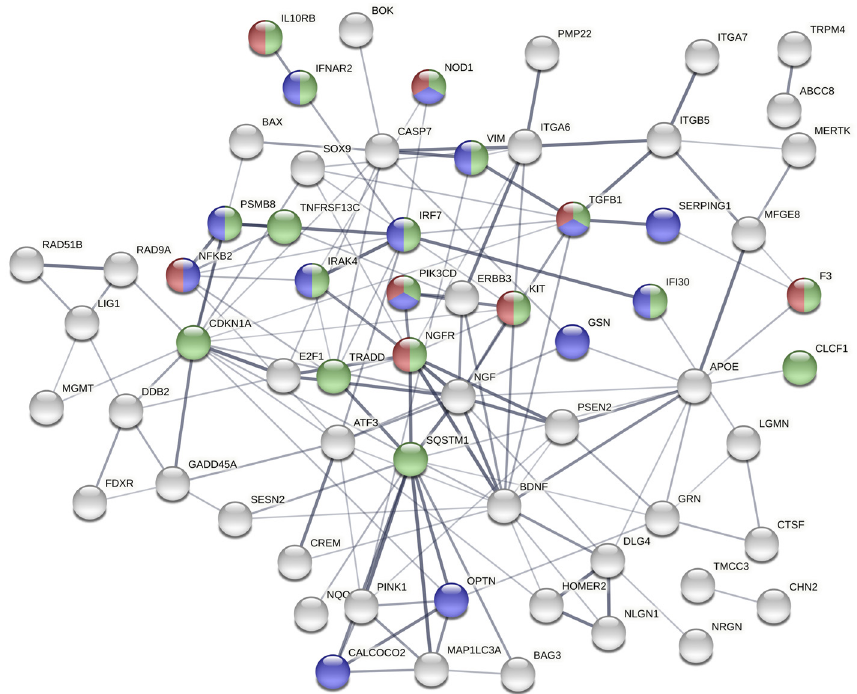
Figure 4. The network of genes induced by epileptogenic exosomes is highly connected and converges on several key pathways. Genes involved in innate immune response ( p = 4.81 × 10 − 5 ), inflammatory response ( p = 0.0035), and cytokine mediated signaling ( p = 9.02 × 10 − 10 ) colored as blue, red, and green, respectively. The most highly connected nodes include SQSTM1 (p62) and CDKN1A (p21).